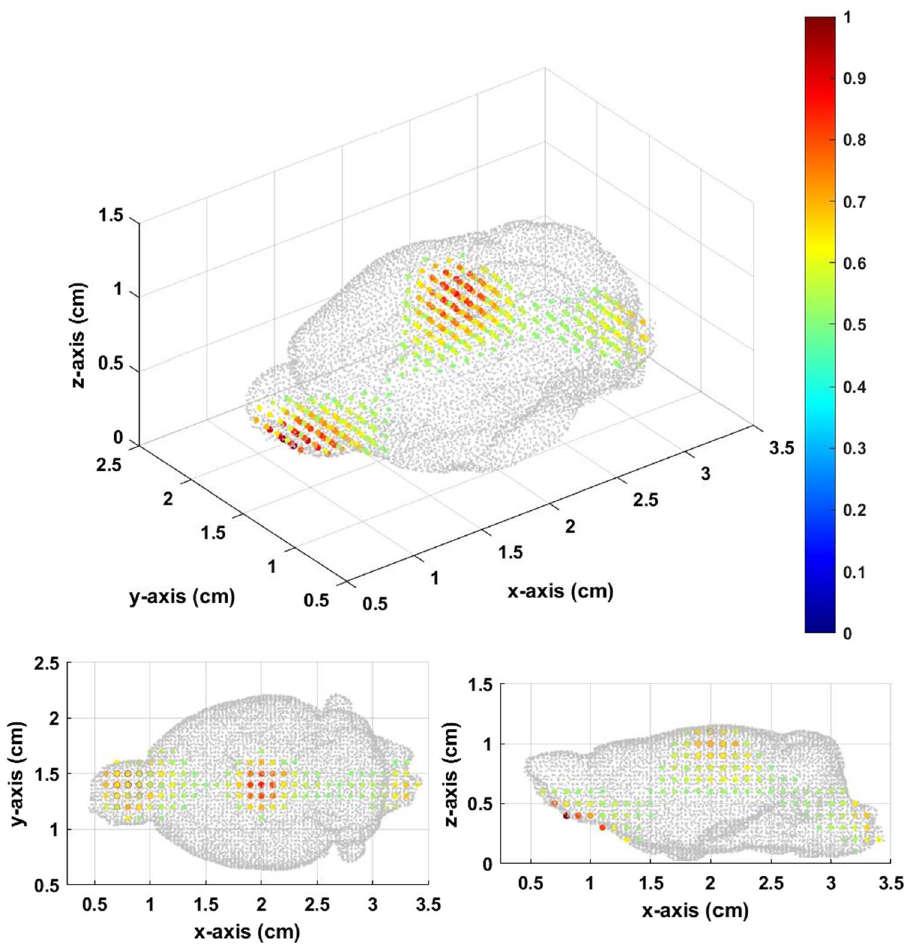
Figure 14. Inverse source distribution from the multiple Z scan (gradient field) with thresholds equal to